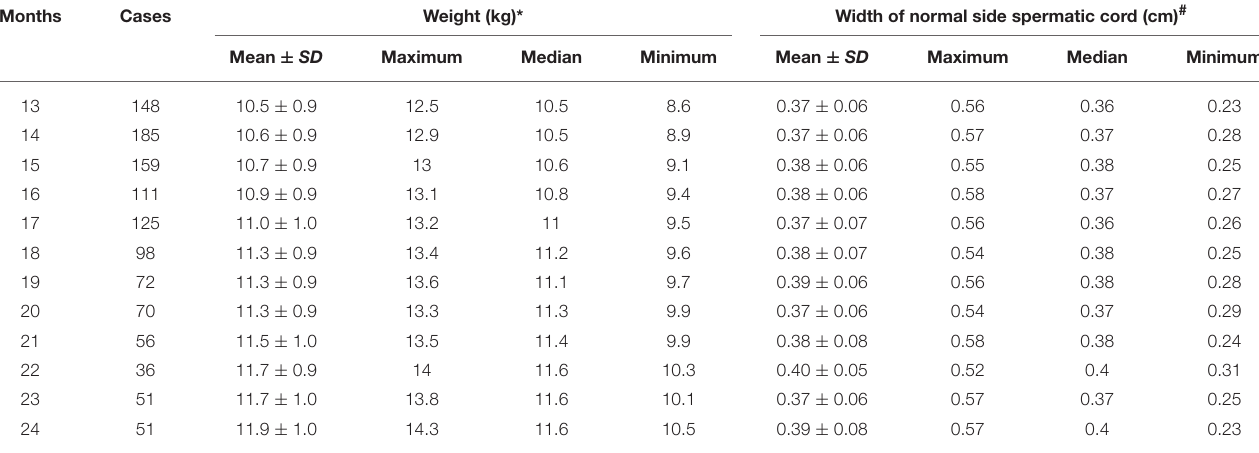
TABLE 2 | Distribution of weight and width of normal side spermatic cord to age groups. Months